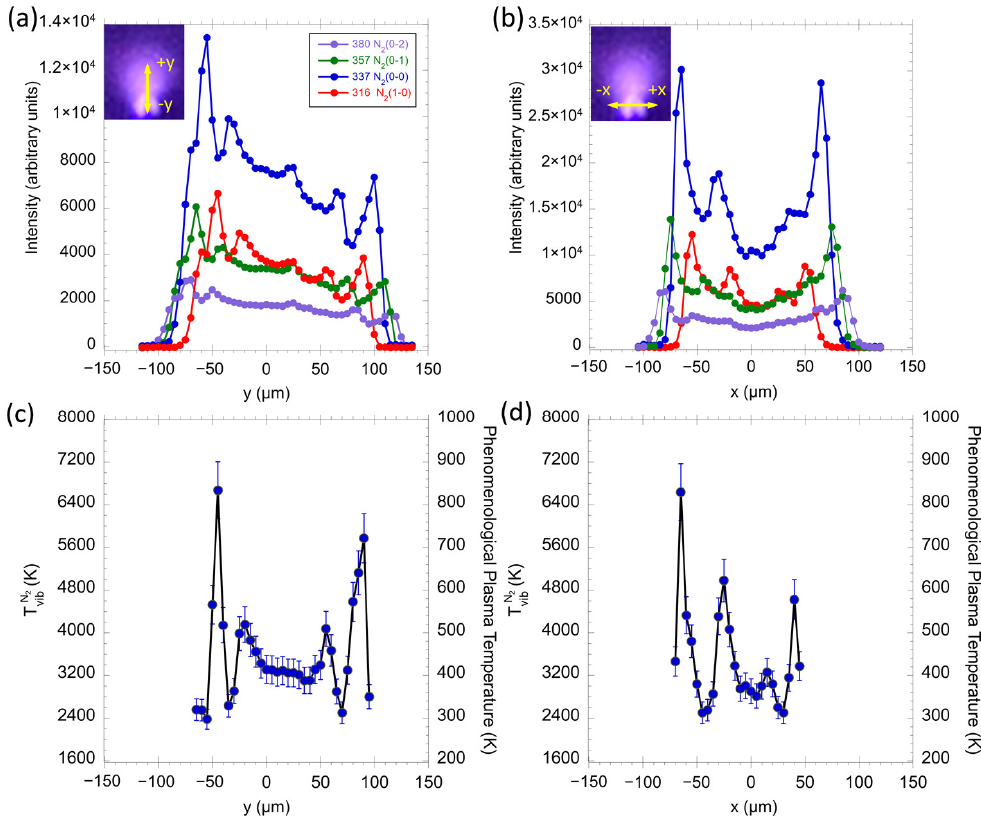
Figure 7. The signal intensity of the N 2 second positive system (C 3 Π –B 3 Π ) along with the ( a ) y and ( b ) x directions; and the derived T N 2 vib and PPT distribution of N 2 along with the ( c ) y and ( d ) x directions. The insert images in ( a ) and ( b ) show the scan directions in the plasma.